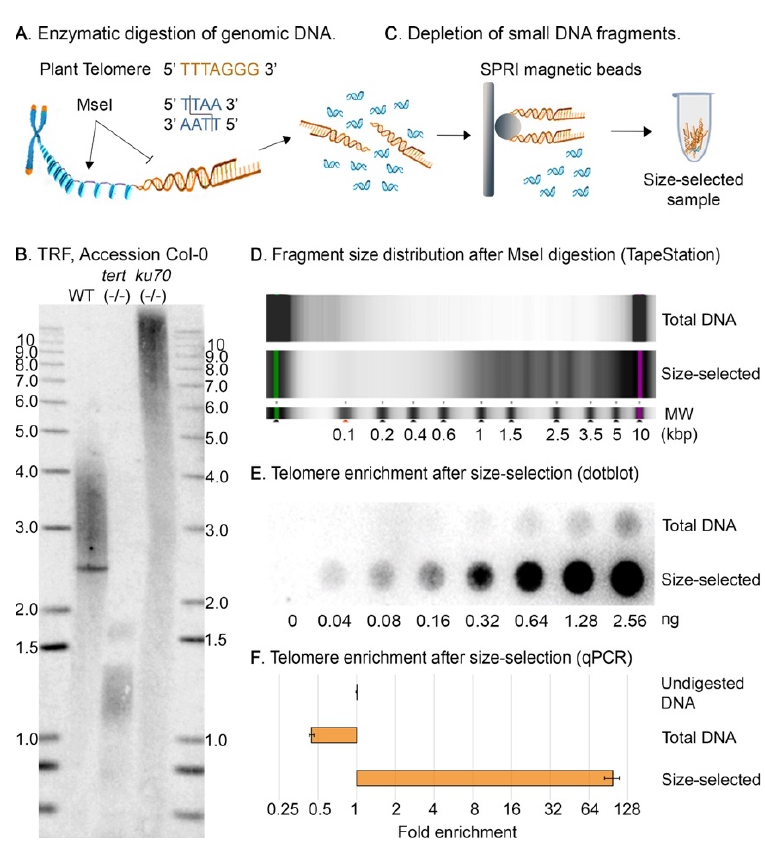
Figure 1. Differential telomere enrichment in solution. ( A ) Schematic representation of plant telomere-biased DNA digestion with Mse I. Mse I cannot recognize the canonical plant telomere repeat, yielding telomeric DNA fragments that are longer than the average size of the rest of the genome. ( B ) TRF showing the longer telomere length of ku70 mutant as compared to wild-type in accession Col-0. The telomerase null mutant ( tert ) is shown for further comparison. tert mutants cannot extend their chromosome ends and have extremely short telomeres. Southern blot with a 32 P-radiolabeled telomeric DNA probe. ( C ) Schematic representation of the telomere enrichment process using the SPRIselect magnetic beads (Beckman Coulter, Brea, CA, U.S.A.). Short incubation time with a low bead-to-sample ratio allows for the selective retention of long DNA molecules, depleting the sample of most of the digested non-telomeric DNA. ( D ) TapeStation outputs displaying the fragment size distribution in the initial (genomic, D5000) and final (telomere-enriched, HS D5000) samples obtained from a ku 70 mutant. ( E ) Dot blot of a two-fold dilution series of the initial and final ku70 samples, hybridized with a 32 P-radiolabeled telomeric DNA probe, demonstrates telomere enrichment after depletion of small DNA fragments in the Mse I-digested samples. ( F ) Telomeric enrichment after size selection determined by qPCR of the telomeric repeat in Mse I-digested samples, and calculated with the 2 −Δ Cq method using undigested genomic DNA as control (Cq is cycle of quantification, also known as Ct or threshold